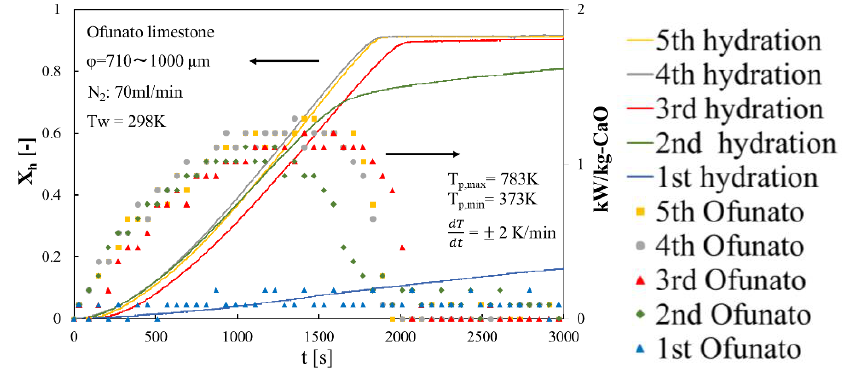
Figure 10. Hydration conversion and the heat output per 1 kg of Ofunato CaO in TGA-51 after decarbonization at 1223 K for 5 h. in muffle furnace.